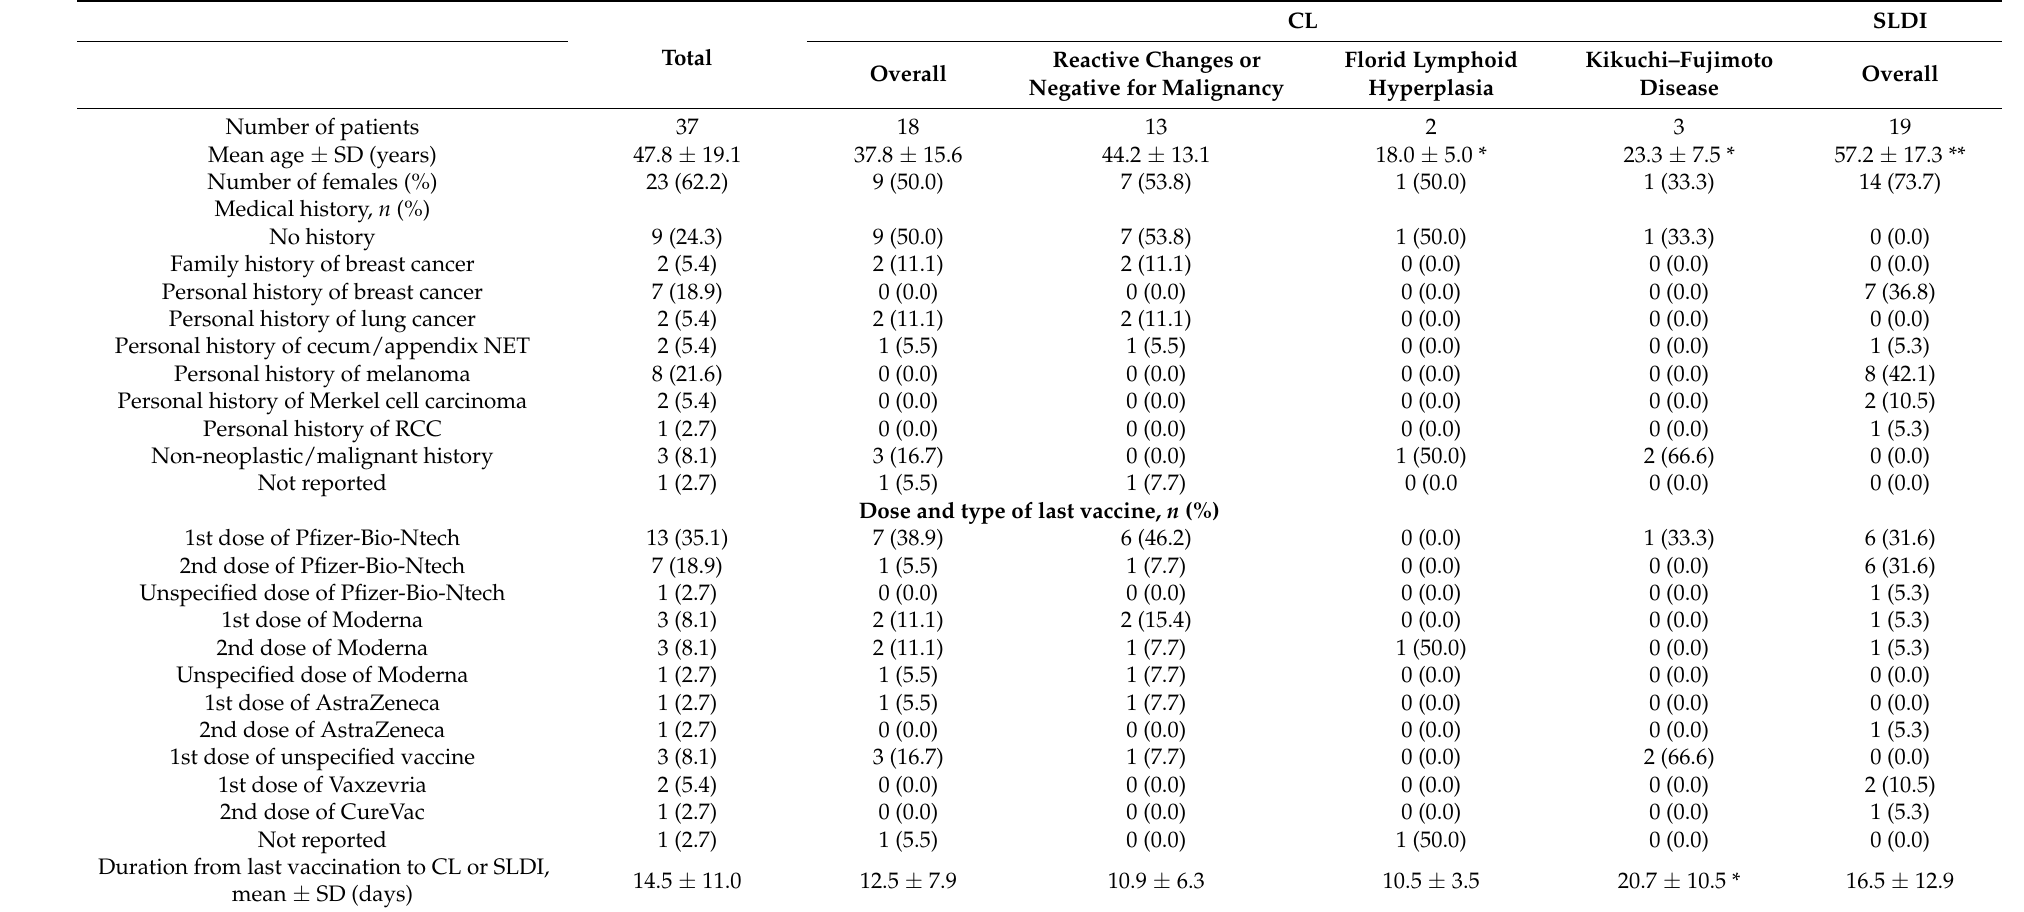
Table 1. Pooled analysis. CL, clinical lymphadenopathy; SLDI, subclinical lymphadenopathy detected on imaging; SD, standard deviation; N, number of; NET, neuroendocrine tumor; RCC, renal cell carcinoma; US, ultrasound; PET/CT, positron emission tomography/computed tomography; MRI, magnetic resonance imaging; KFD, Kikuchi–Fujimoto Disease; FNA, fine-needle